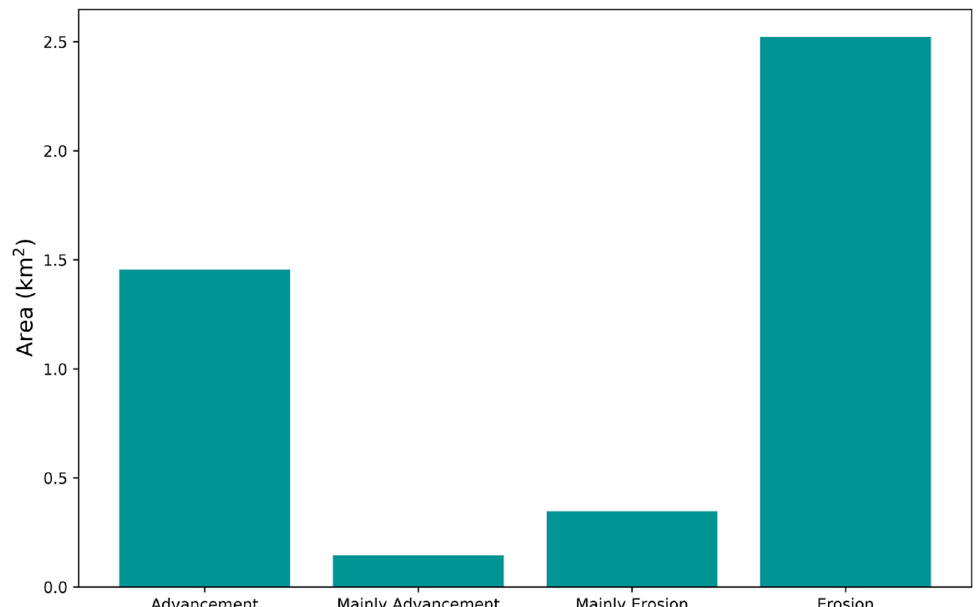
Figure 3. Spatial variation of the investigated coastal area. Analysis of the shorelines in the last 142 years allows identification of the sectors in constant advancement (progradation) and those in constant erosion, those mainly in advancement and those mainly in erosion. In the histogram, the amount of territory that always experienced advancement, always erosion, mainly advancement and mainly erosion was quantified according to the analyses of spatial variation of the shorelines (Figure 2).